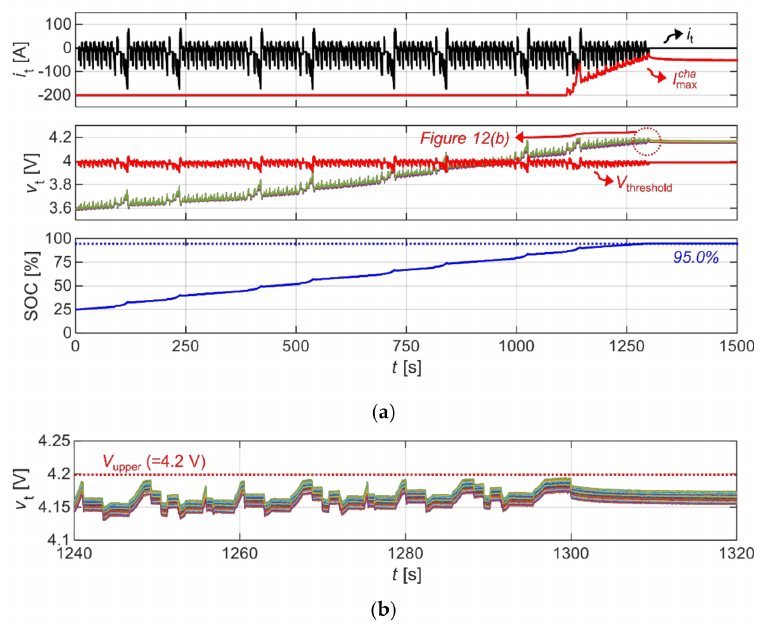
Figure 12. Experimental results for the counterpart (neglecting cell inconsistencies): ( a ) i t , v t , and SOC; ( b ) the enlarged v t of the cells during 1070.0–1150.0 s.